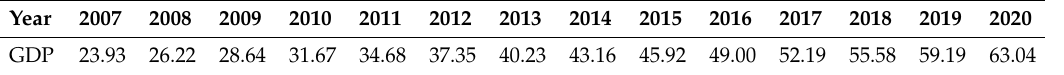
Table 5. The gross domestic product (GDP) of China (2005 price, trillion Renminbi